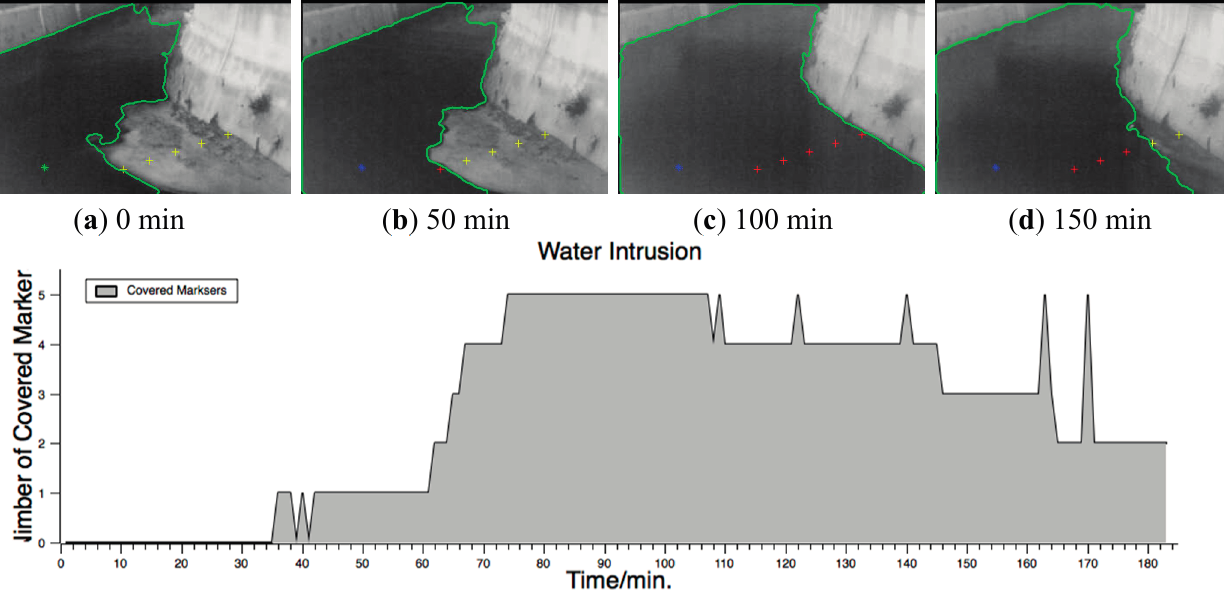
Figure 8. Water intrusion on specific ground measured using IR photography. ( a – d ) show the visual sensing results from screen shots every 50 min; and ( e ) the graph generated using the number of the virtual markers covered by the waterbody against